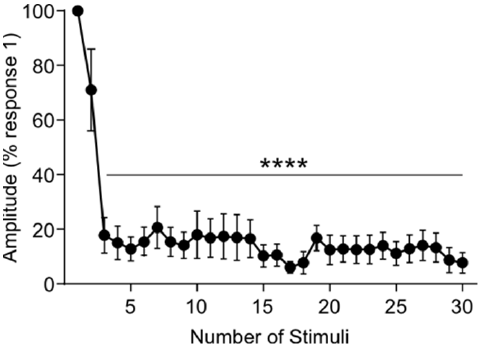
Figure 7. High-frequency pulse train with tSCS. TEP amplitude was recorded in response to a 30- pulse train of high frequency (100 Hz) tSCS at suprathreshold (1.4 T, motor threshold) intensity. TEP amplitude was significantly decreased compared to pulse number 1 from pulses 3 through 30. **** p <